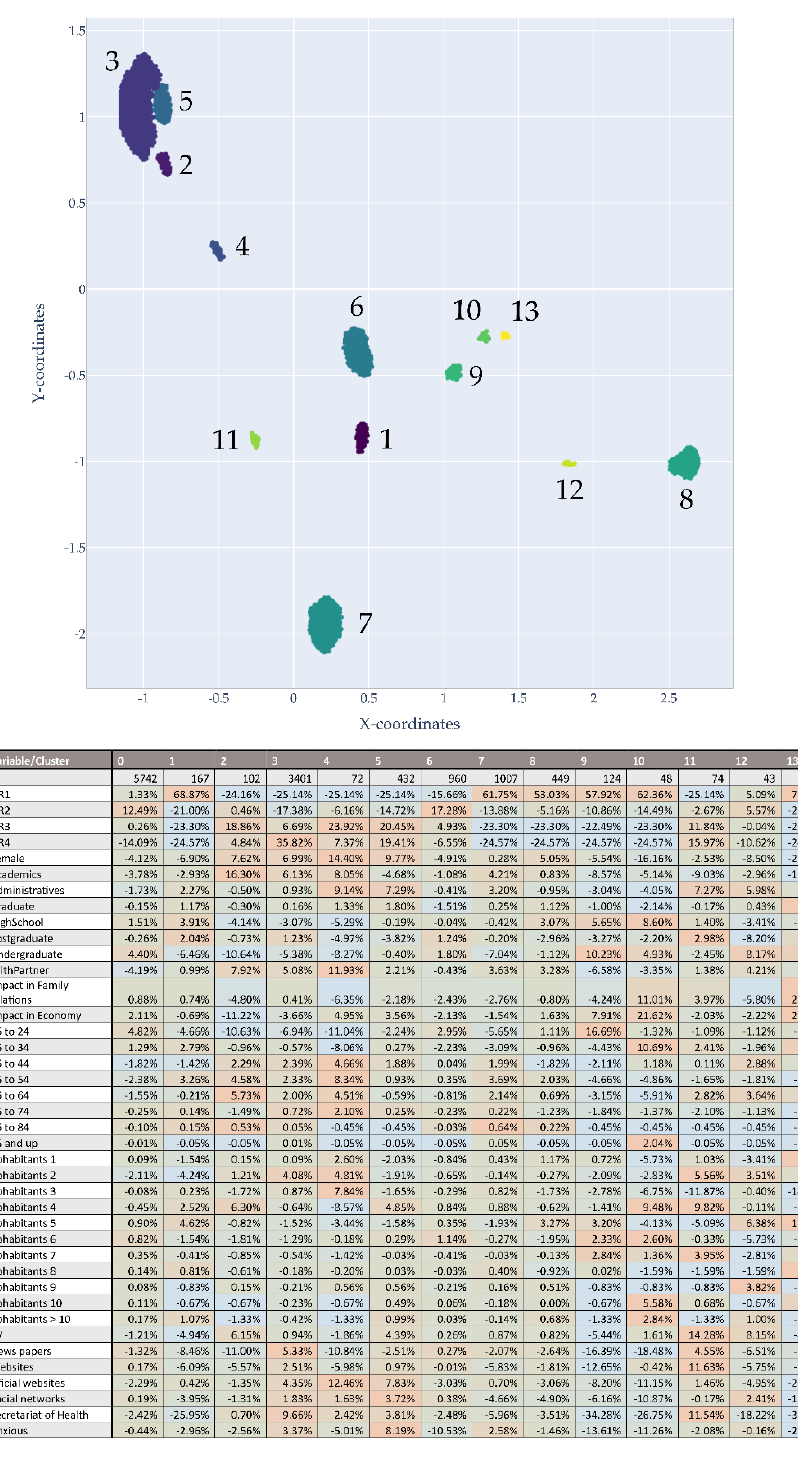
Figure 6. Groups obtained after the network and cluster methods. The table below illustrates the new population distribution by group, with prevalence of risk perception, gender, age, emotions and media consumption by group. The colour red indicates a higher prevalence compared to the group resulting from the